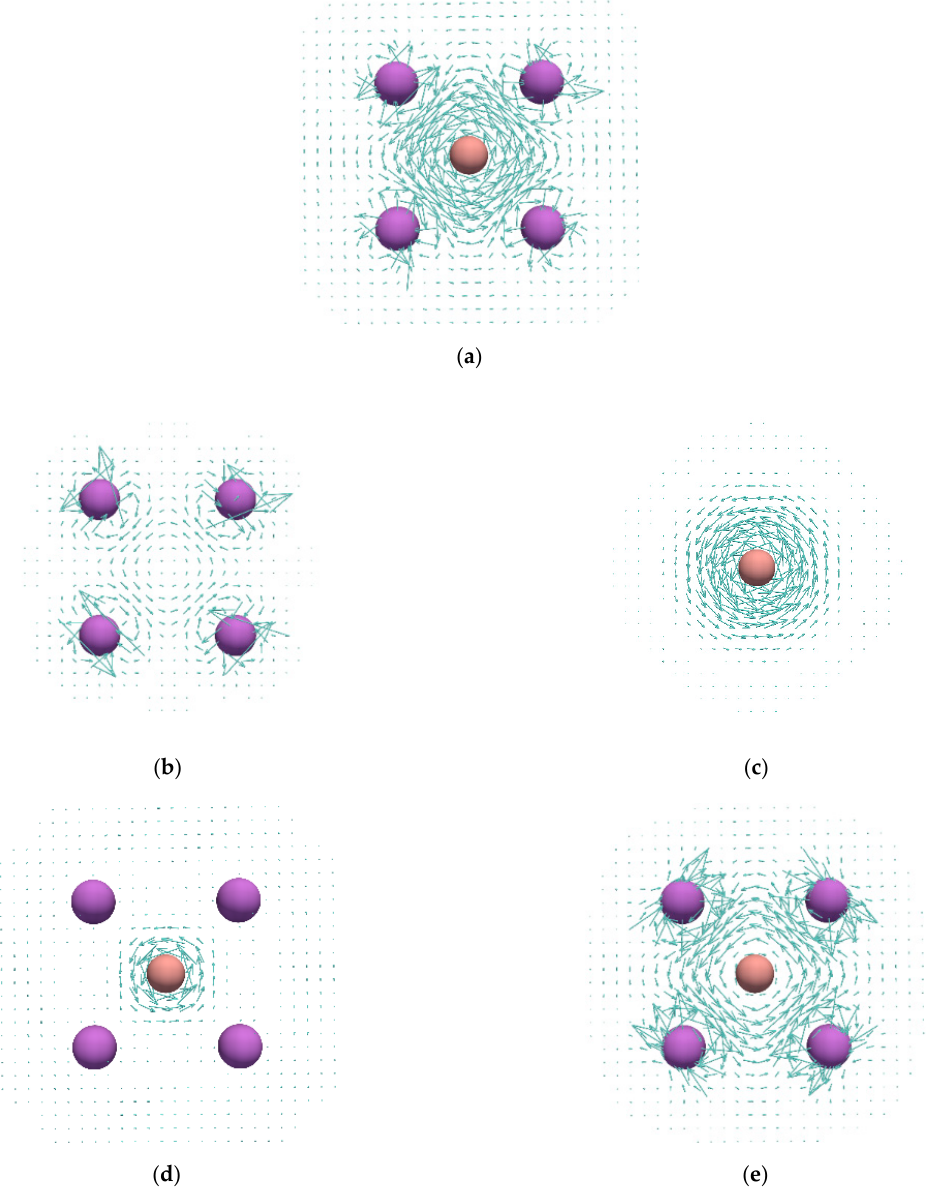
Figure 4. Current density maps calculated in the plane of the Li-atom ring: Li 4 B 2 ( a ), Li 42+ ( b ), HOMO of Li 4 B 2 ( d ), doubly degenerate HOMO-1 of Li 4 B 2 ( e ); current densities plotted in the plane that perpendicularly bisects the B–B bond of the B 22 − fragment extracted from the optimized geometry of Li 4 B 2 ( c